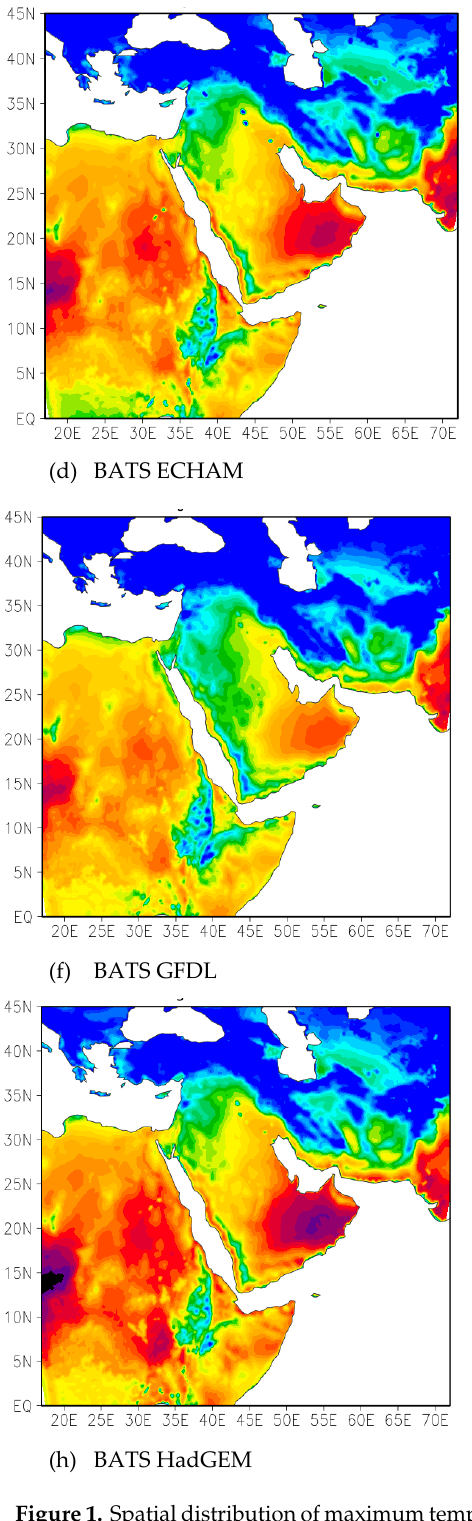
Figure 1. Spatial distribution of maximum temperature (°C) for ( a ) CRU, ( b ) ERA–Int BATS, ( c ) ERA–Int CLM, ( d ) ECHAM6 BATS, ( e ) ECHAM6 CLM, ( f ) GFDL BATS, ( g ) GFDL CLM, ( h ) HadGEM BATS, and ( i ) HadGEM CLM averaged over the period 1980–2005.